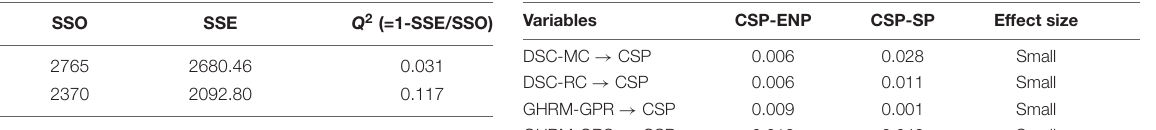
TABLE 7 | Construct cross-validated redundancy. TABLE 8 | Effect size ( f 2 ).